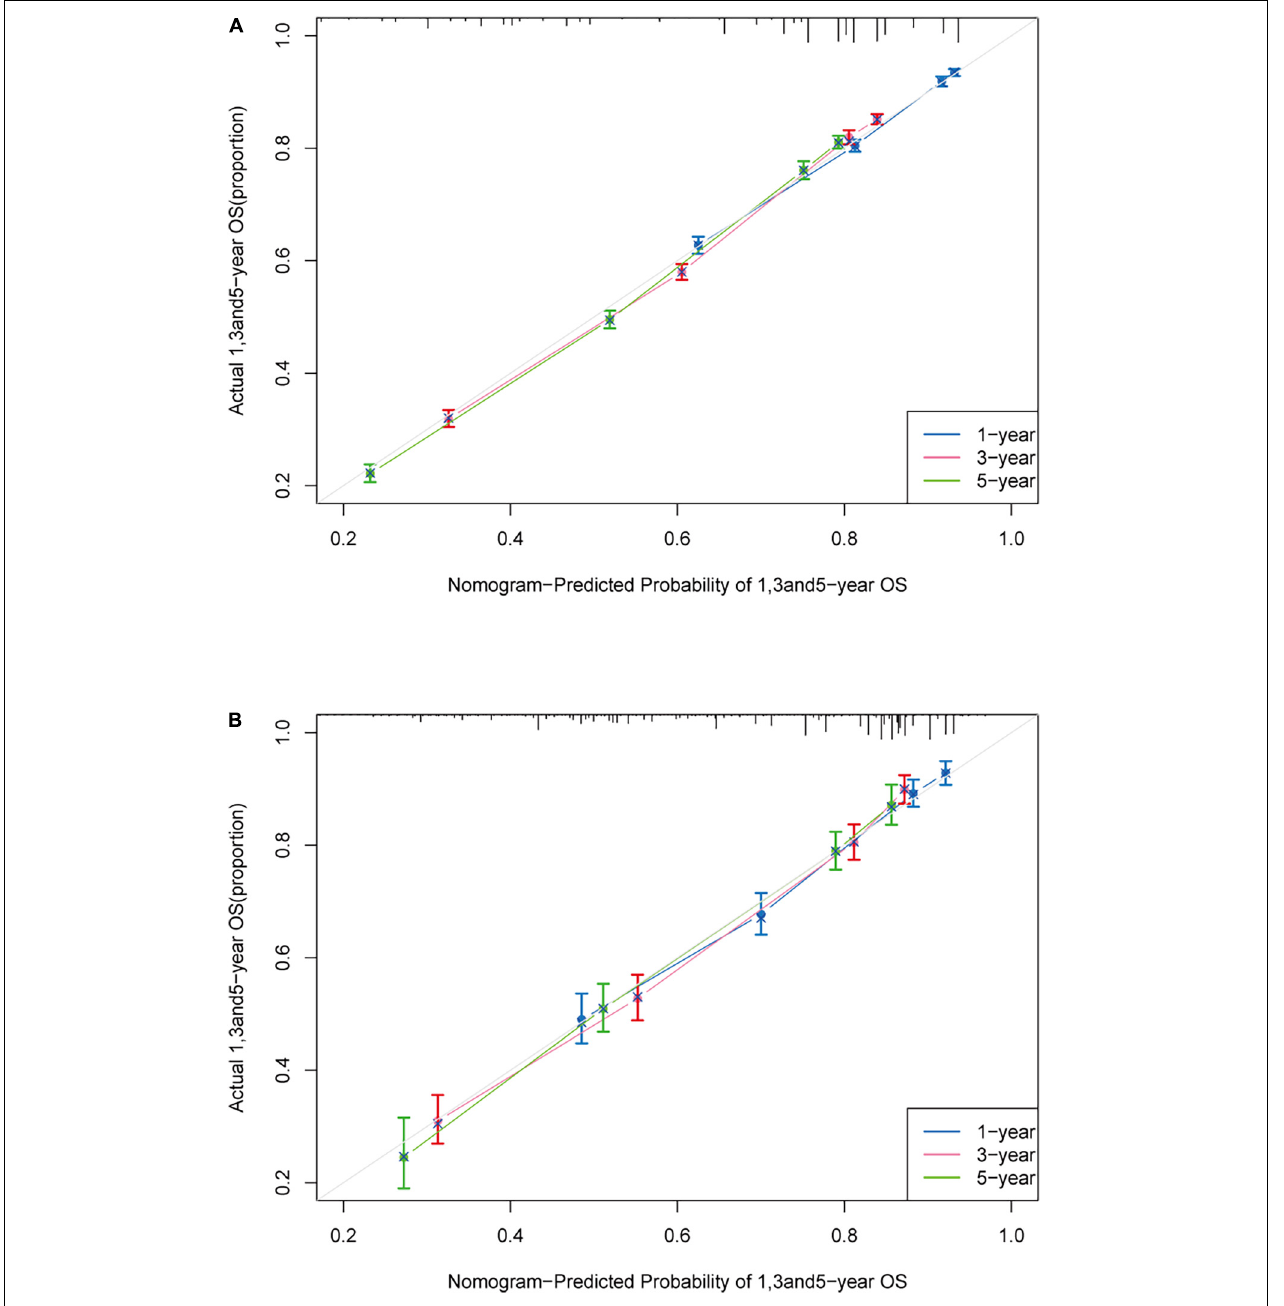
FIGURE 2 | Calibration plot. Calibration curve of the nomogram both in the training and validation cohort. Predicted survival probability produced by nomogram is x -axis, and actual survival is y -axis, close alignment with 45 degrees diagonal represents the good estimation. (A) 1-, 3-, and 5-year OS of the training cohort; (B) 1-, 3-, and 5-year OS of the validation